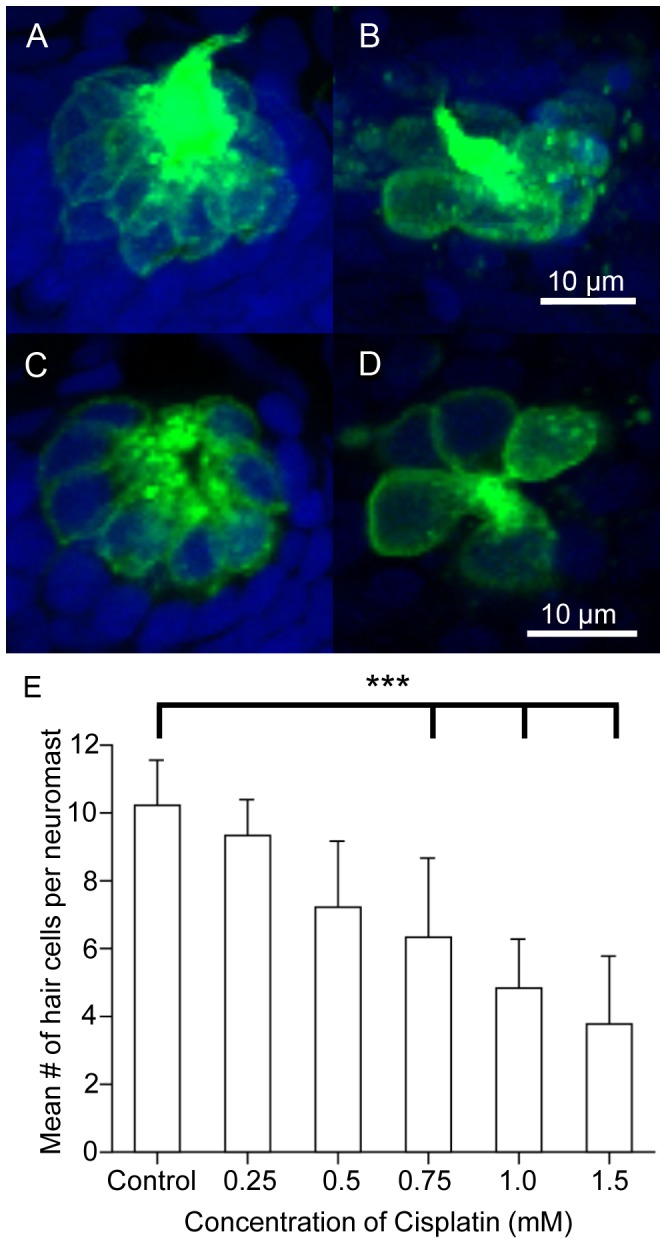
Dose response curve following cisplatin treatment.Five-days post-fertilization Brn3c-GFP transgenic zebrafish were exposed to varying doses of cisplatin for four hours to determine at which dose approximately 50% of the hair cells die. The larvae were fixed, co-labeled with the nuclear dye TO-PRO-3 (blue), and the GFP-tagged hair cells (green) in the O2 neuromast were imaged using confocal microscopy. (A–B) Z-stack projections of two O2 neuromasts under different treatment conditions showing the entire neuromast structure. (C–D) Slices from the same neuromasts as in A, B demonstrating the membrane-bound GFP label surrounding the nuclear dye. (A, C) Hair cells appear normal in untreated controls. (B, D) Noticeably fewer hair cells are found in larvae treated with 1 mM cisplatin. (E) The mean number of hair cells per O2 neuromast (± SD) decreased as the dose of cisplatin increased when compared to untreated controls. n = 9−31 neuromasts for each treatment group. ***p<0.001 when individual treatments are compared to untreated controls.